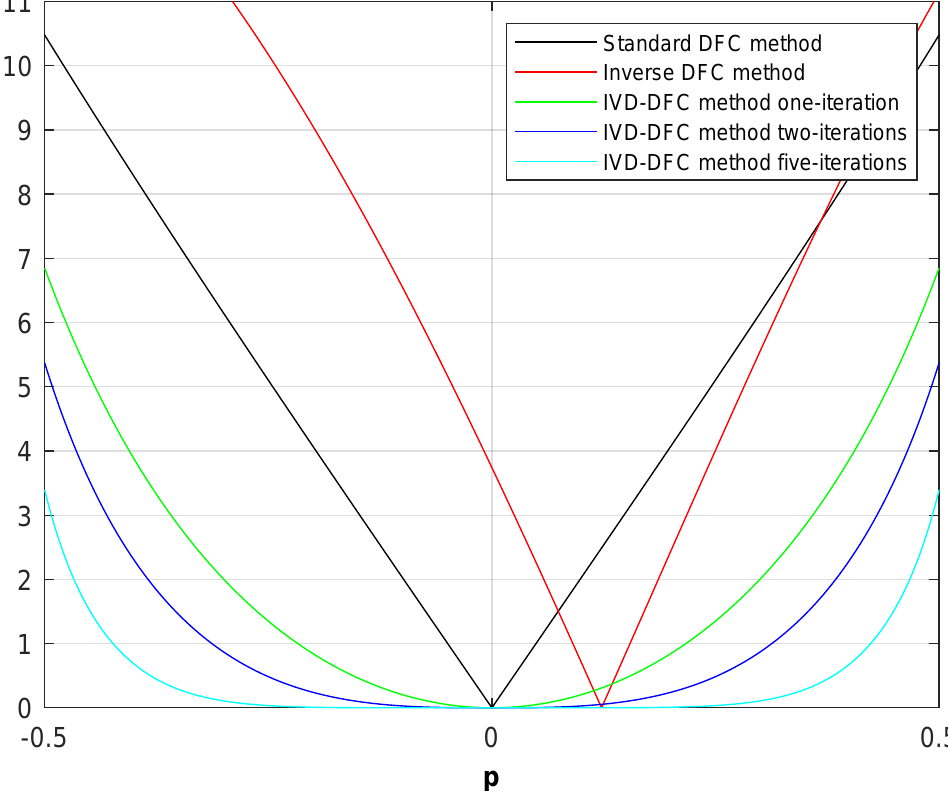
Figure 6. Comparison of the position standard deviation errors of the presented methods. The plot is referred to a machine with the following inductance values: L 0 = 442.2 µH, M 0 = 20.7 µH, L 2 = 103.3 µH. The parameter M 2 is let vary between L 0 + M 0 M 0 L 2 in order to get the p range between and L 0 − −